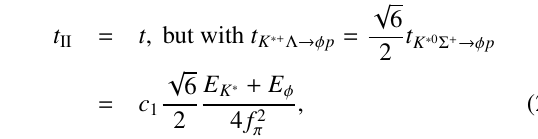
Figure 10. The square of the triangle amplitude t Λ in Fig. 7(B) for the Λ -exchange as a function of the invariant mass of φ p